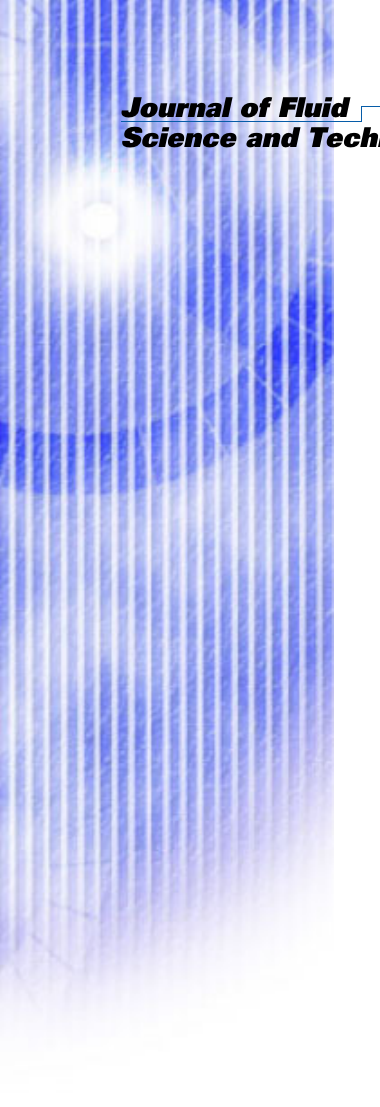
Fig. 7 Ensemble-averaged time histories of conditionally sampled velocity and wall static pressure corresponding to the valley